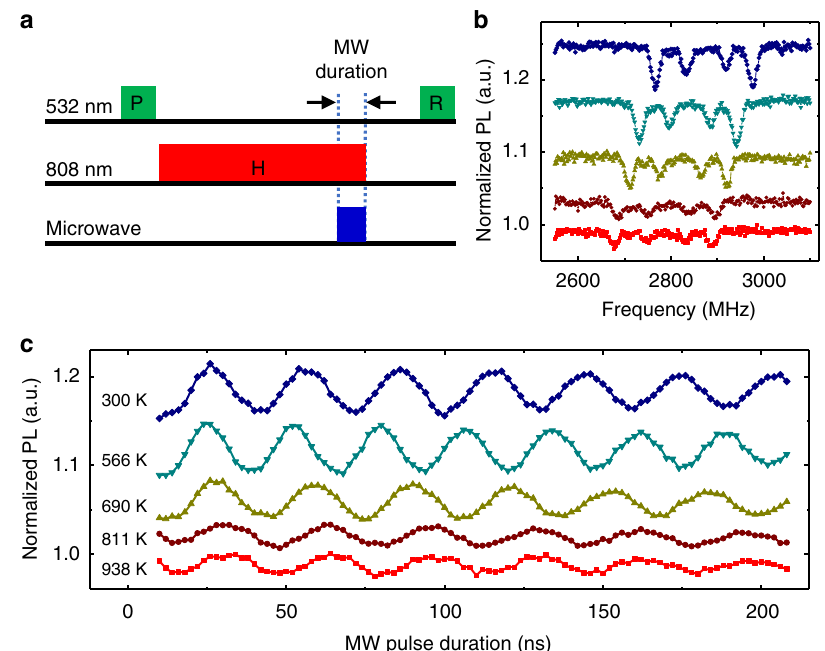
Fig. 4 Rabi oscillations of nitrogen-vacancy (NV) center spins in a nanodiamond (ND) at temperatures approaching to 1000 K. a Pulse sequence. The microwave driving is applied after the temperature reaches the stationary value (the NIR laser pulse duration being 5 μ s). b Optically detected magnetic resonance (ODMR) spectra and c Rabi oscillations of NV center spins in the ND at different temperatures (indicated by different colors as shown in c ). An external magnetic fi eld of about 38 Gauss is applied in these measurements. The temperature is extracted from the zero- fi eld splitting (ZFS) D from the D - T relation in Fig.